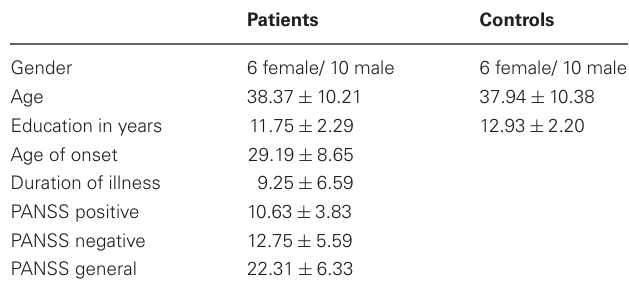
Table 1 | Demographic and clinical characteristics of the patient and control